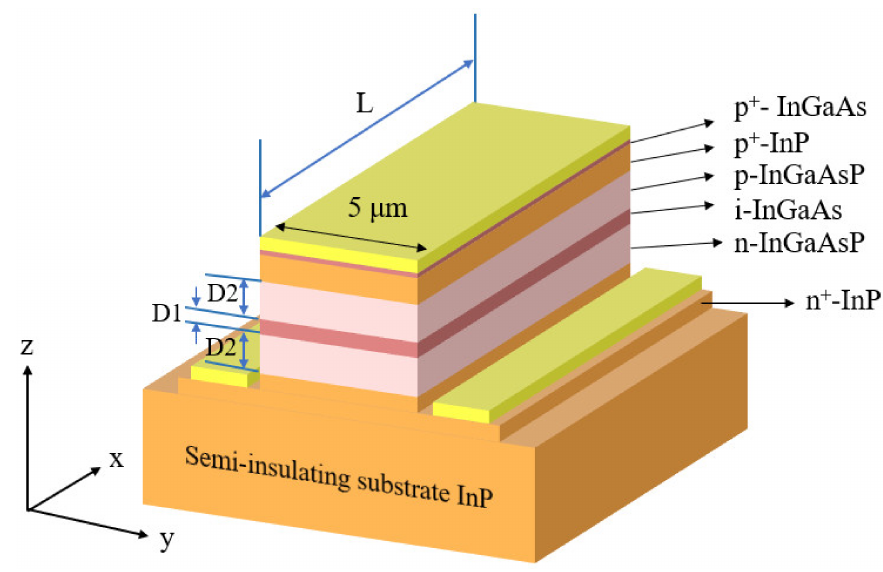
Figure 1. The three-dimensional schematic structure of the single photodetector